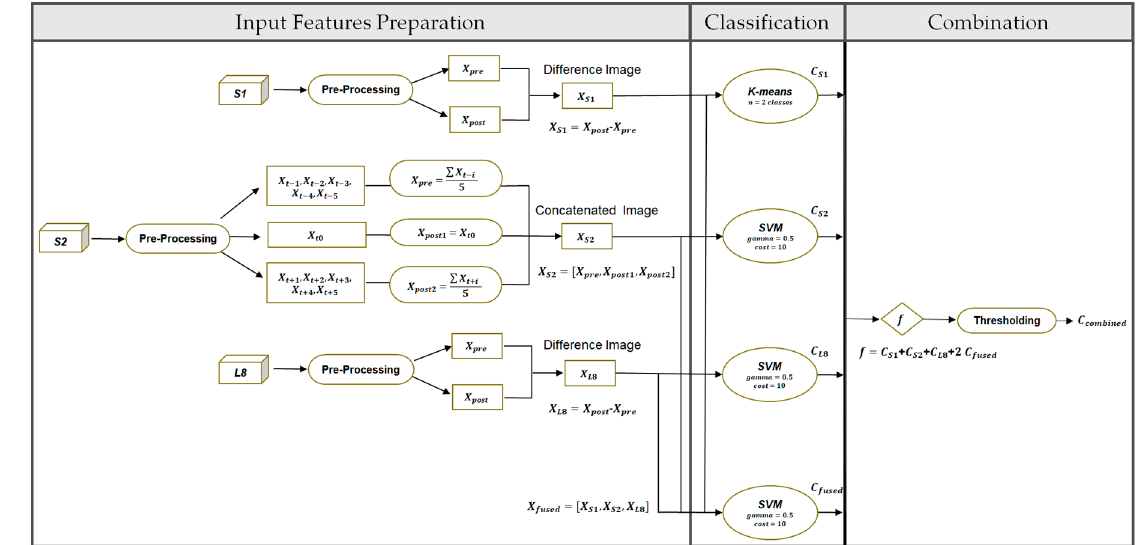
Figure 3. General block scheme representing the three main steps of the ML algorithm: (i) Input Features Preparation, (ii) Classification, and (iii) Combination.